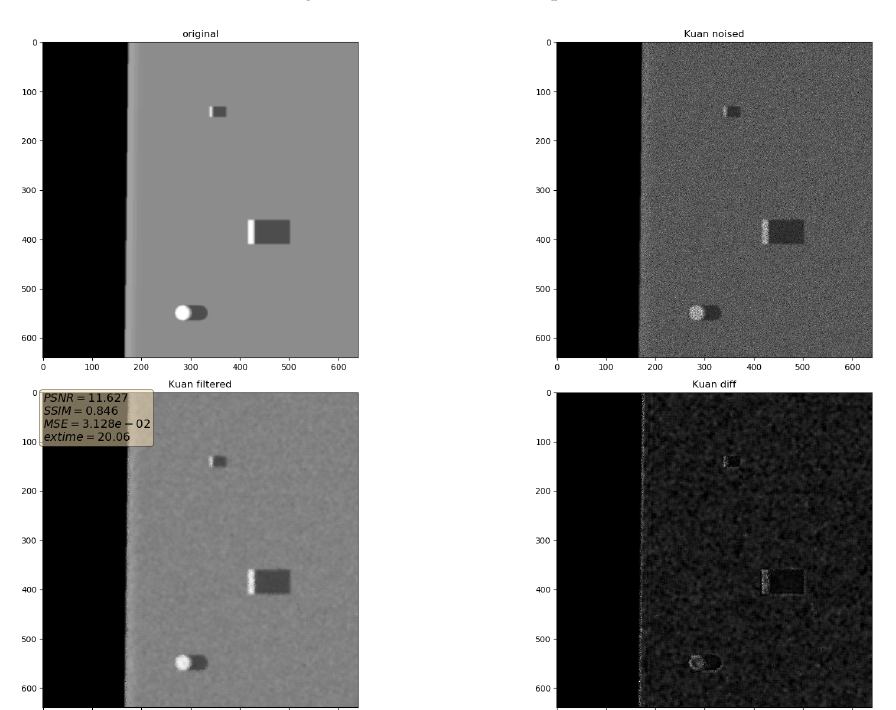
Figure 11. Filtering results for Kuan filter. Speckle noise σ 2 =